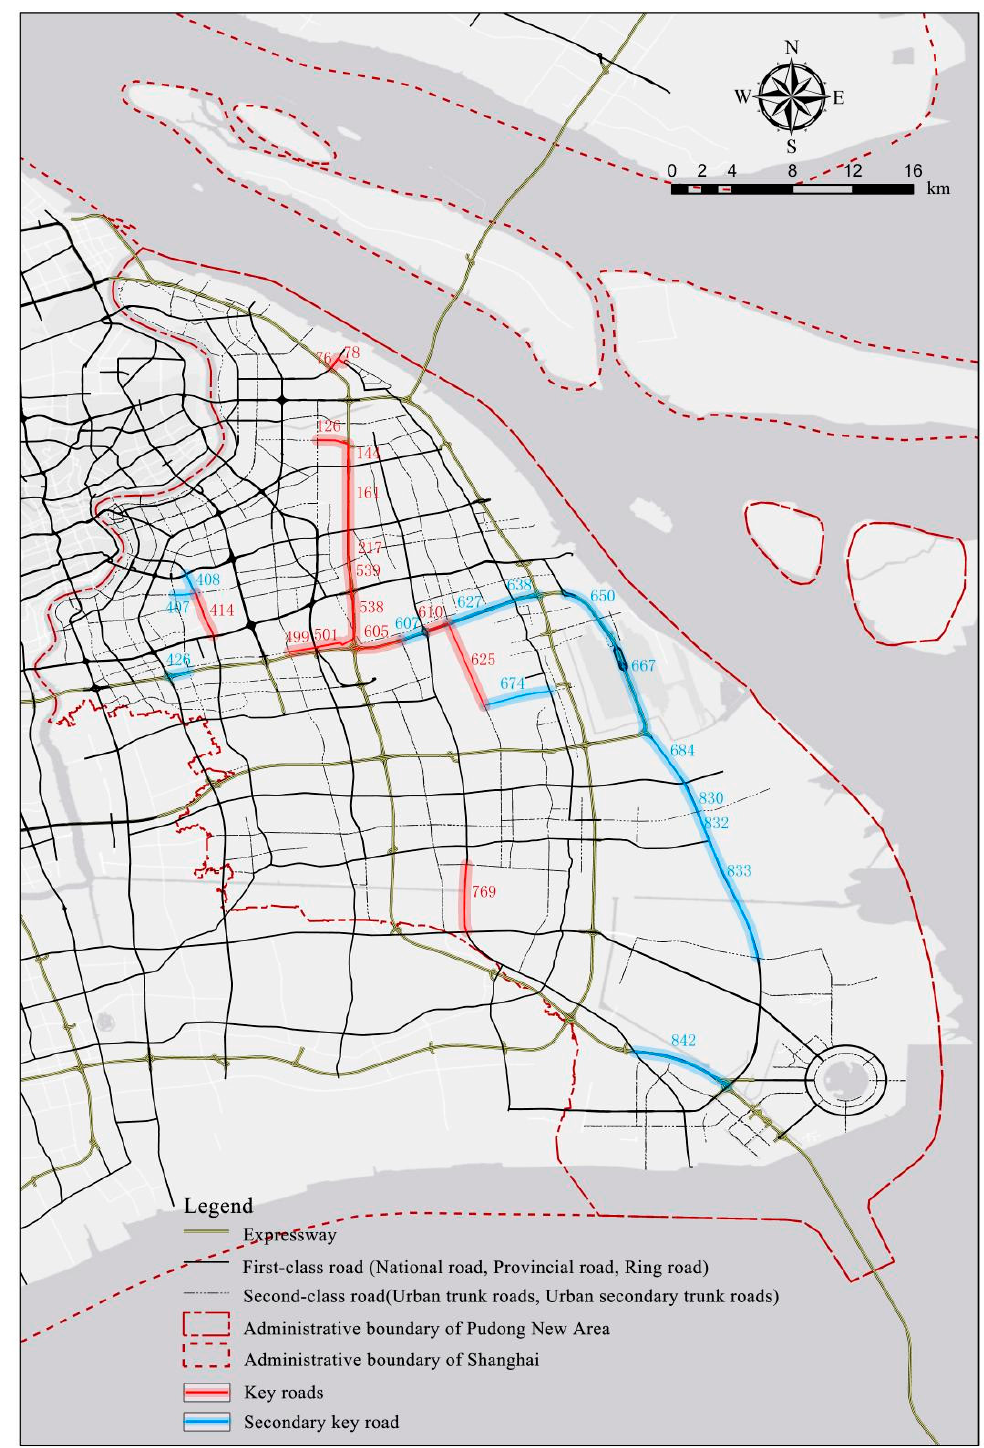
Figure 13. Spatial distribution of the key sections and secondary key sections. (Source: self-drawn by the author).